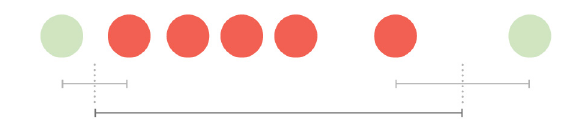
FIGURE 1 | Visualization of the estimated duration of an atrial fibrillation episode measured by spot-checks. The time between the last green spot-check (no AF) and the first red spot-check (AF) divided by two, plus the time between the first and last red spot-check, plus the time between the last red spot-check and the first green spot-check divided by